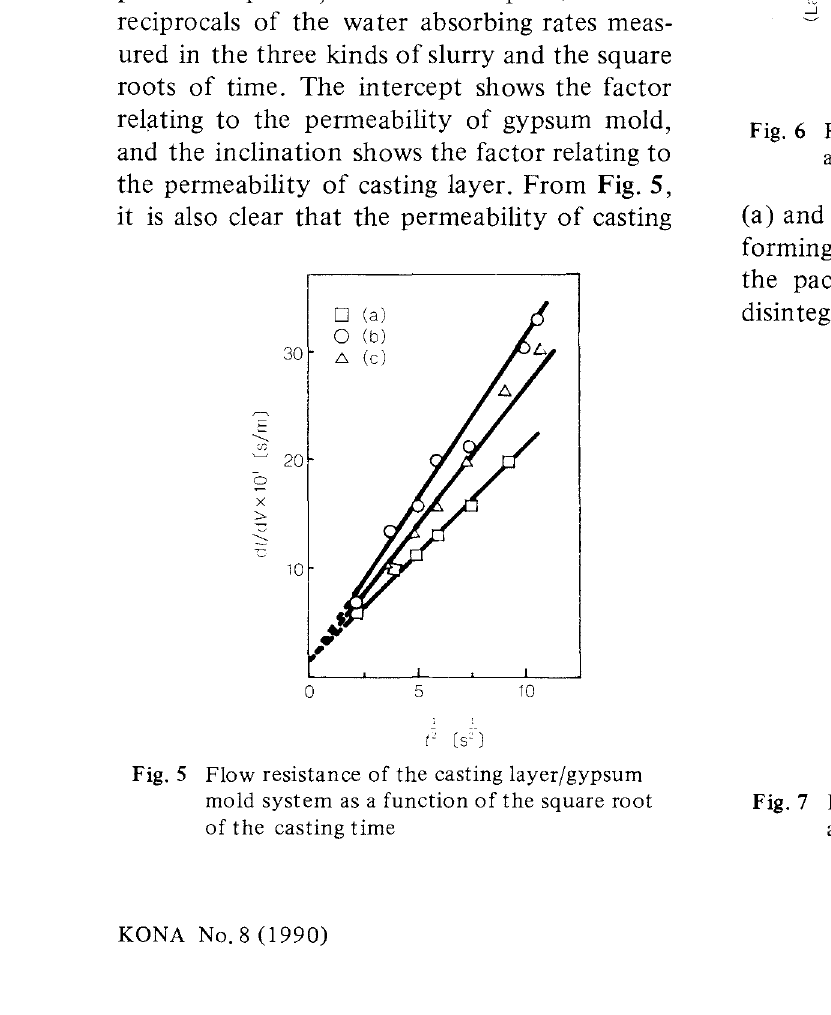
Fig. 7 Relation between the porosity of casting layer and the layer